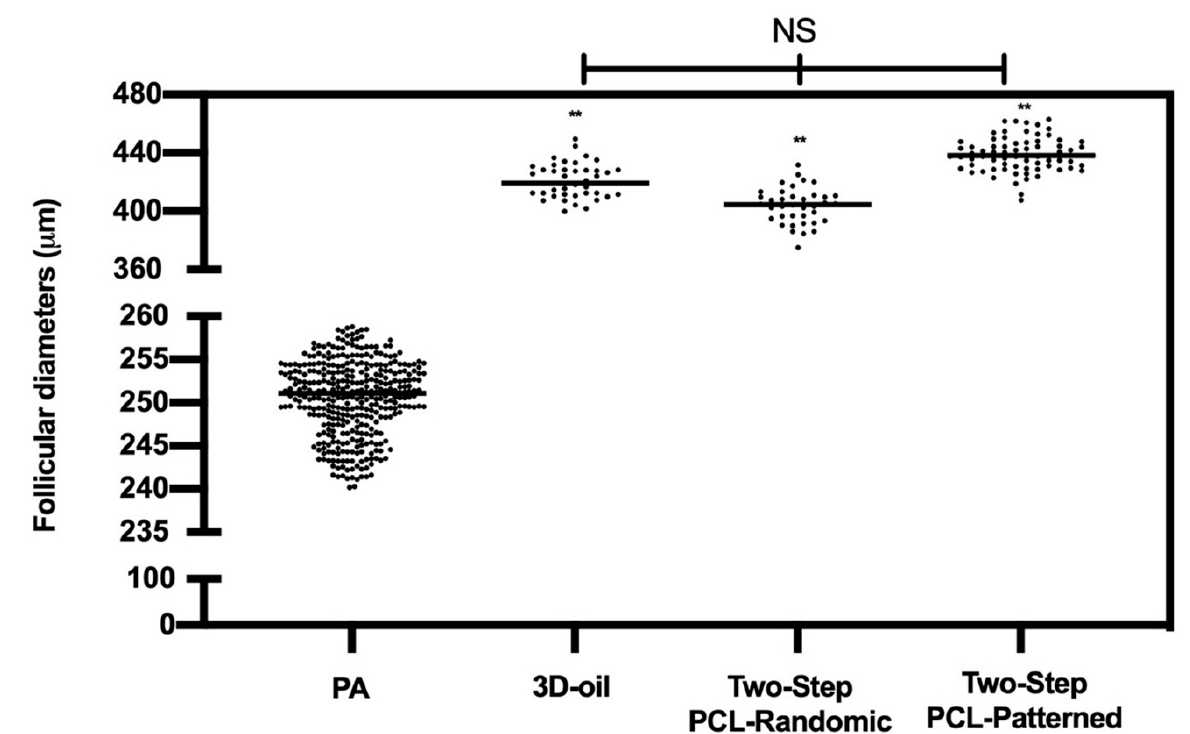
Figure 5. EA follicular mean final diameters: overview for each experimental group. A total of 120, 125, and 122 follicles were cultured in three independent experiments during which 3D-oil, Two- Step PCL-Randomic, and Two-Step PCL-Patterned electrospun scaffolds were simultaneal com- pared (3D-oil: 40, 40, and 40 PA follicles per experiments; Two-Step PCL-Randomic: 41, 42, and 42